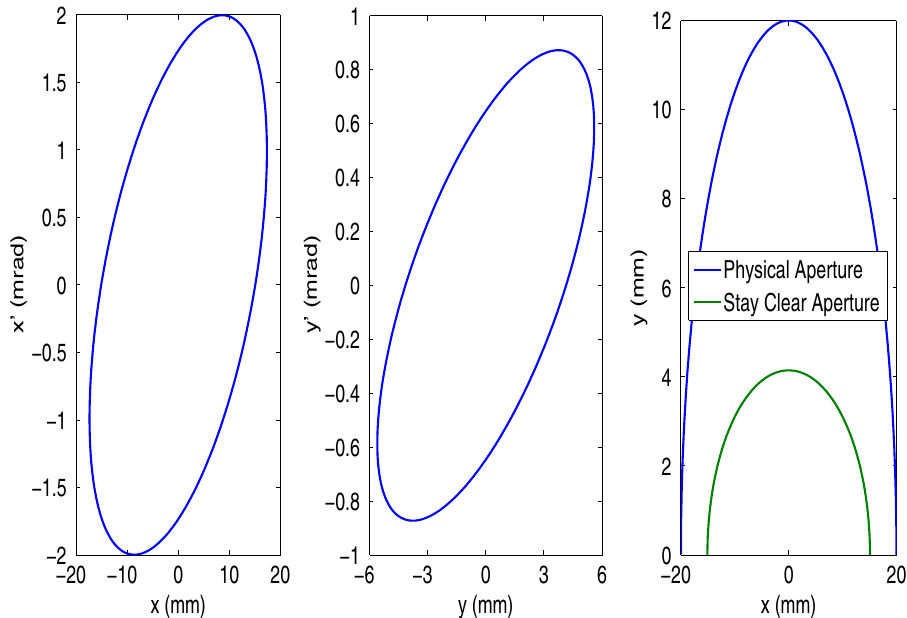
FIG. 2. The stay clear aperture at the end of the injection straight. The left plot is the horizontal phase-space boundary, the center plot is the vertical phase-space boundary. The right plot shows the physical aperture compared to the stay clear aperture at the end of the injection